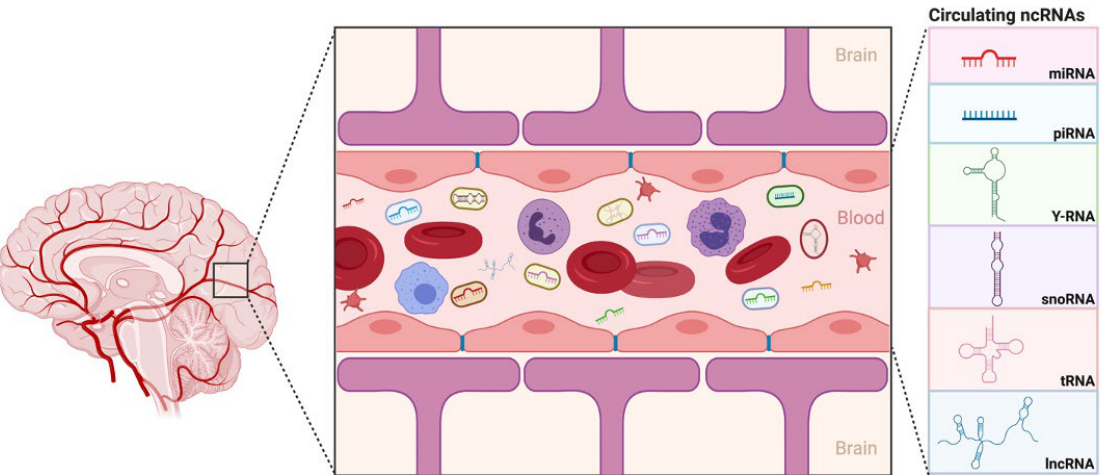
Figure 6. Executive Summary. Circulating ncRNAs as biomarkers, isolated from plasma, that can be used to distinguish severe ASD cases from mild ones and hence could be possibly applied as early diagnostic biomarkers. Created with